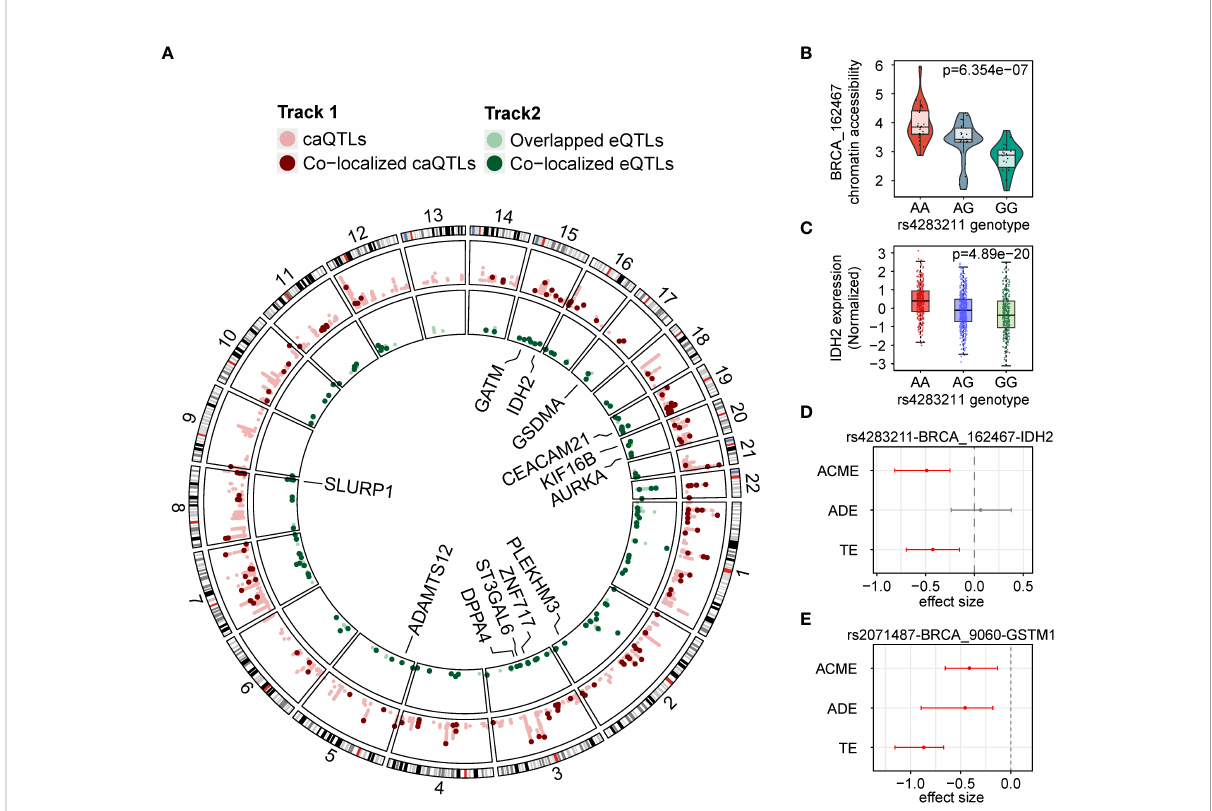
FIGURE 3 caQTLs overlapped with eQTLs. (A) Circos plot of colocalized caQTLs and eQTLs. Outer track lighter red, caQTL SNPs. Outer track darker red dots colocalized caQTL SNPs. Inner track lighter green, eQTL variants overlapped with caQTL SNPs. Inner track darker green dots colocalized eQTL variants. (B) Distribution of chromatin accessibility of BRCA_162467 in groups with different genotypes of rs4283211. (C) Distribution of expression of IDH2 in groups with three different genotypes of rs4283211. (D) Effect sizes in mediation analysis on the rs4283211- BRCA_162467- IDH2 pair. ACME, average causal mediation effects; ADE, average direct effects and TE, total effect. (E) Effect sizes in mediation analysis on the rs2071487-BRCA_9060- GSTM1